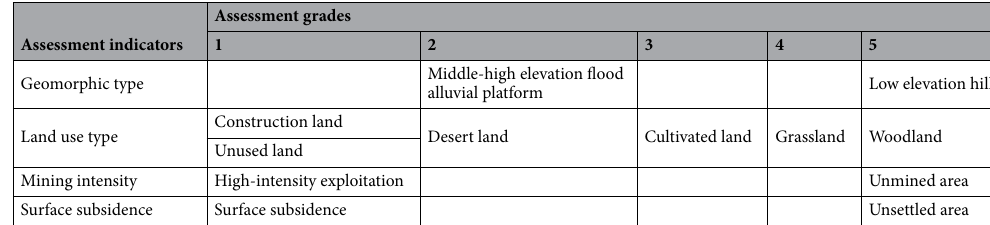
Table 3. Determination of evaluation grade of qualitative